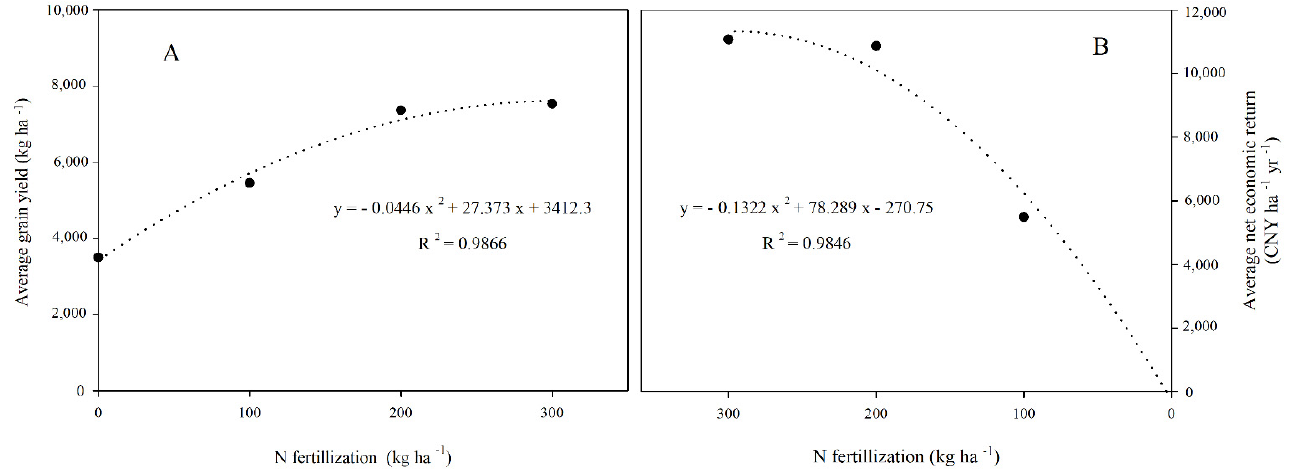
Figure 6. Average grain yield ( A ) and net economic return ( B ) as functions of N application rate. The data of grain yield and net economic return were the average value of the 7-year experiment.